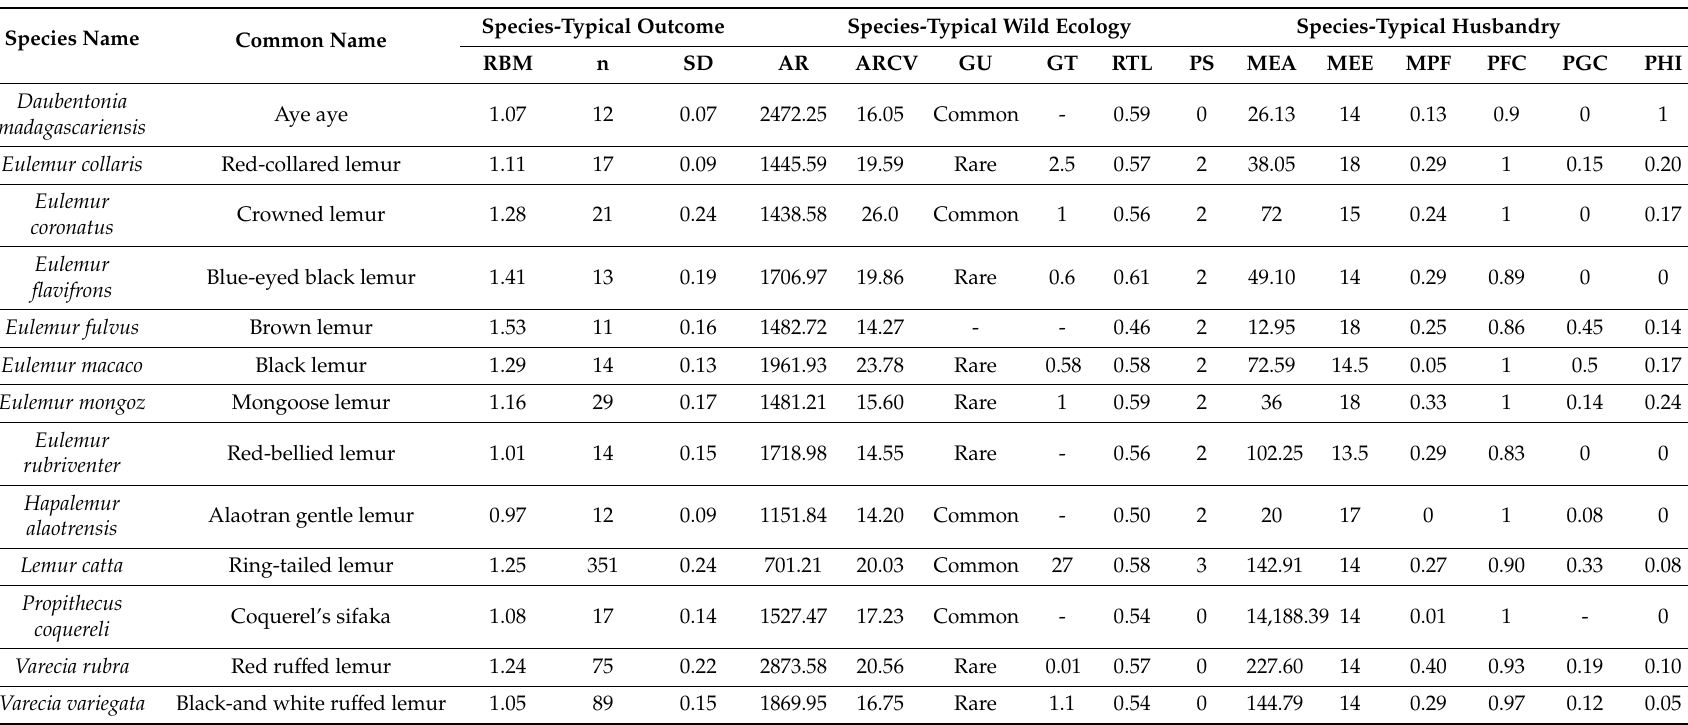
Table 3. Details of species-typical variables used during comparative analyses. Acronyms are explained at the foot of the table. Species-typical outcome and husbandry data processing and calculations are described in Section 2.2.1 and Table 1. Justification and calculation of species-typical wild ecology predictors are detailed in Table 2. Dashes indicate data were not available for that